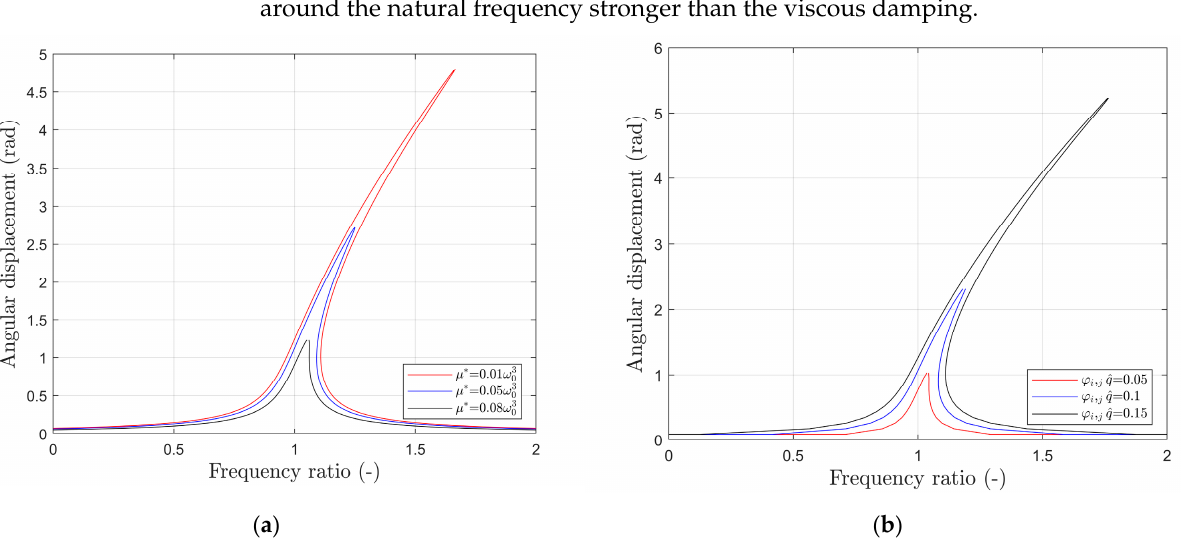
, d ∗ = 0 , d ∗ = 0.05 ω 0 , µ ∗ = 0